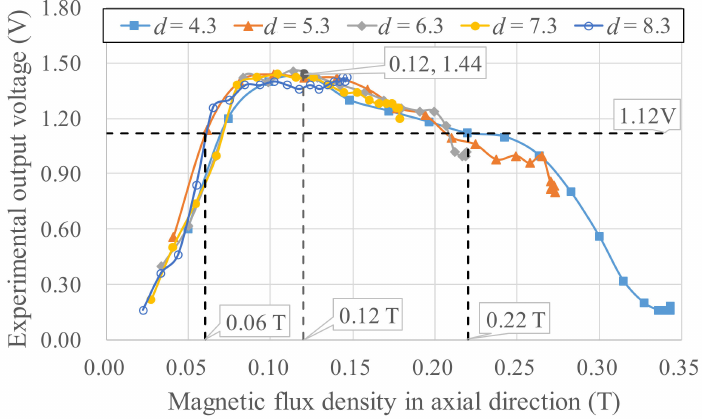
Figure 12. Correlations between the magnetic flux densities and the output voltages in the experiments.